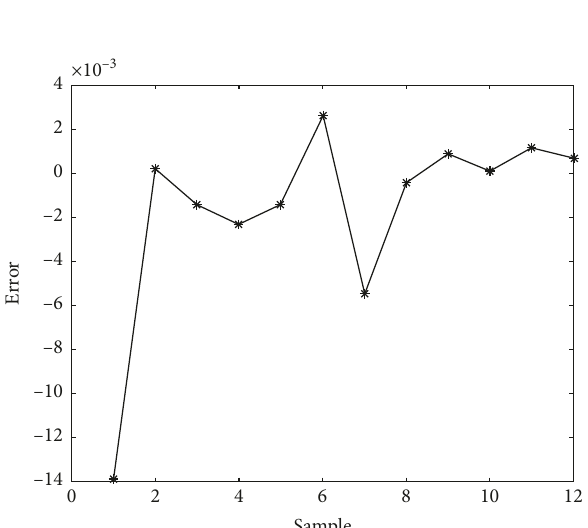
Figure 4: The BPNN output.